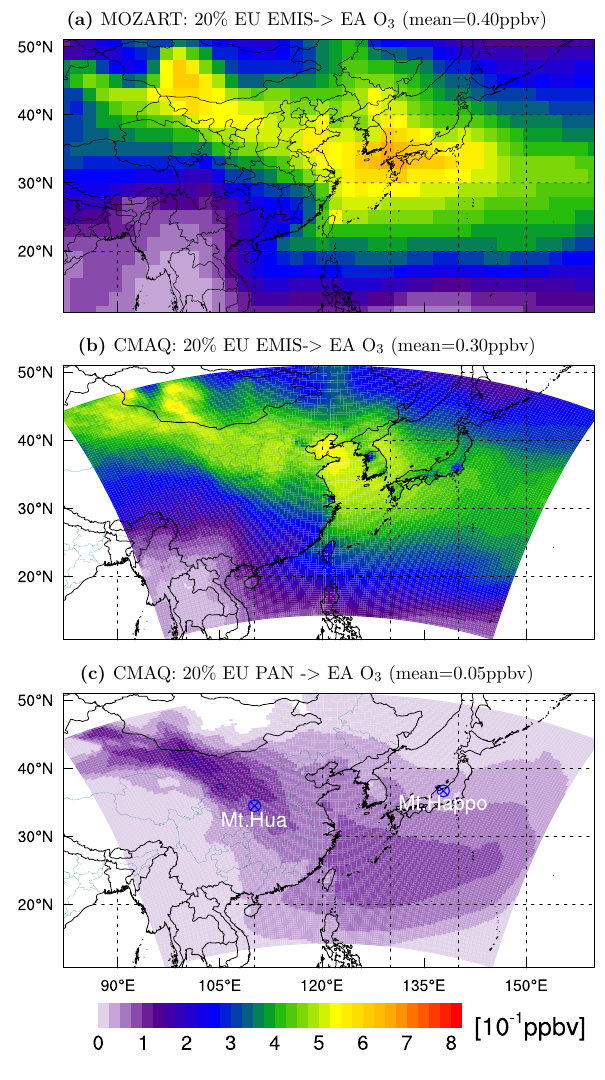
Figure 7. Monthly mean O 3 response to a 20% reduction in European anthropogenic emissions of O 3 Fig. 7. Monthly mean O 3 response to a 20% reduction in Euro- precursors for March 2001. The lower panel shows CMAQ inferred contribution of O 3 production driven by PAN decomposition associated with European emission perturbations. Circles in the lower pean anthropogenic emissions of O 3 precursors for March 2001. panel denote Mount Hua (34.5 ◦ N, 110.1 ◦ E, 2064m) in central China and Mount Happo (36.7 ◦ N, The lower panel shows the contribution of O 3 production driven by 137.8 ◦ E, 1850m) in central Japan PAN decomposition in association with European emission pertur- bations. Circles denote Mount Hua (34.5 ◦ N, 110.1 ◦ E) in central China and Mount Happo (36.7 ◦ N, 137.8 ◦ E) in central